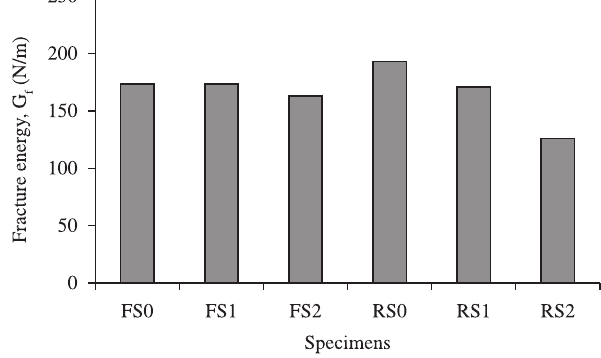
Figure 5. Load vs. Mid-span Displacement of recycled sand textile reinforced polymer mortar.